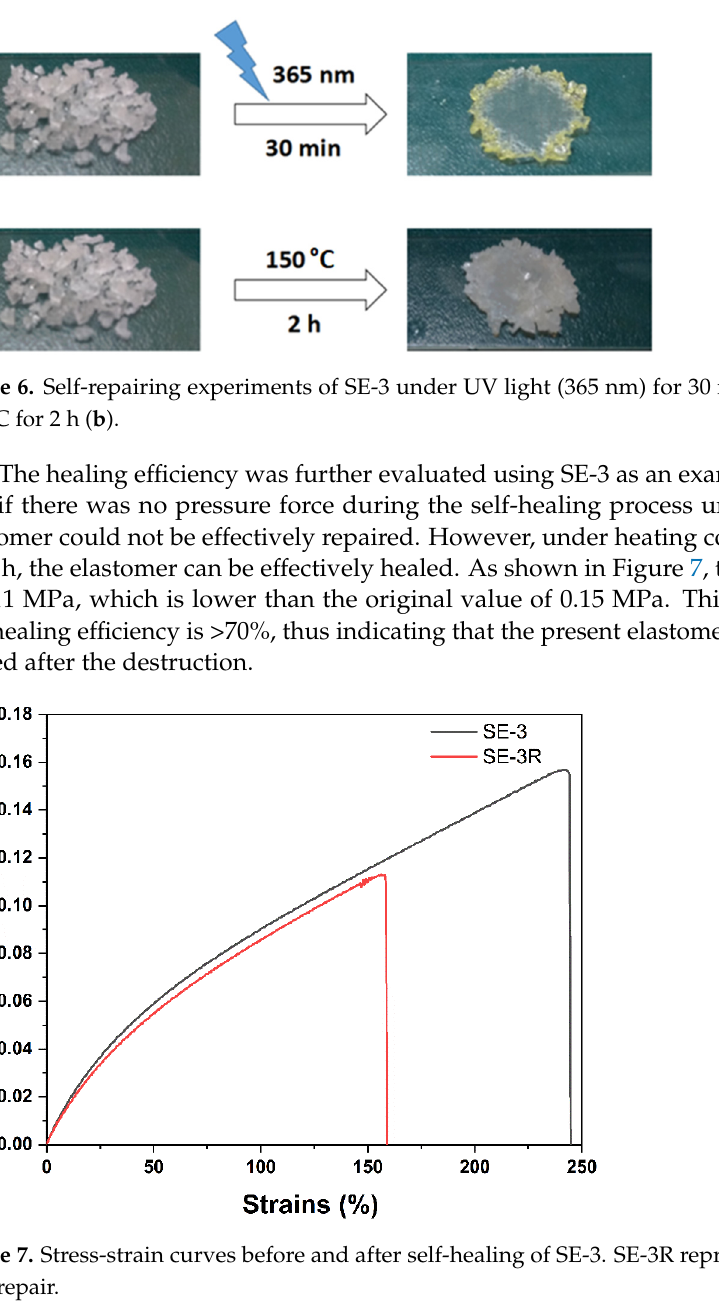
Figure 5. The DSC curves of SE-3, SE-12, and SE-17.